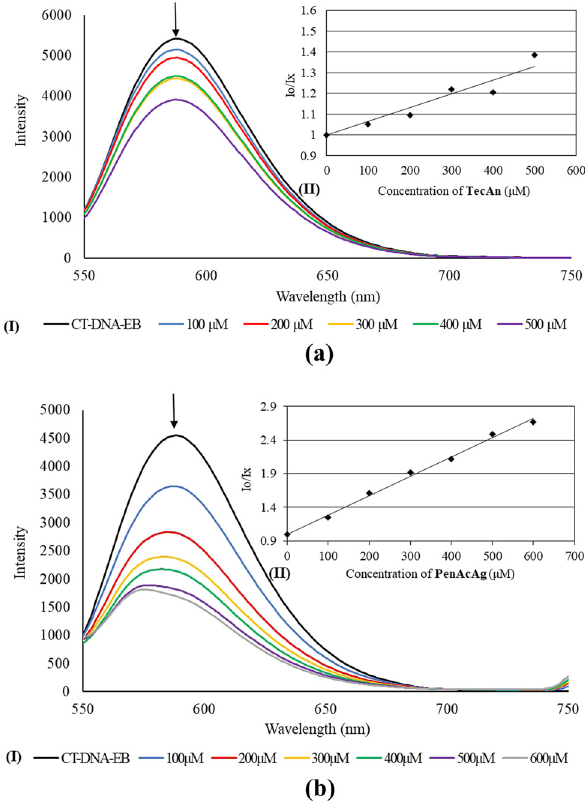
Figure 10: ( I ) Emission spectrum of CT - DNA - EB complex in the pre - sence of TecAn ( a ) and PenAcAg ( b ) ([ EB ] = 2.3 μ M [ DNA ] = 26 μ M [ complex ] = 0 – 600 μ M ) λ = 527 nm. The arrow shows that the ex intensity changes upon increasing the complex concentration. ( II ) Inset shows the plots of emission intensity I I x vs [ complex ] o /